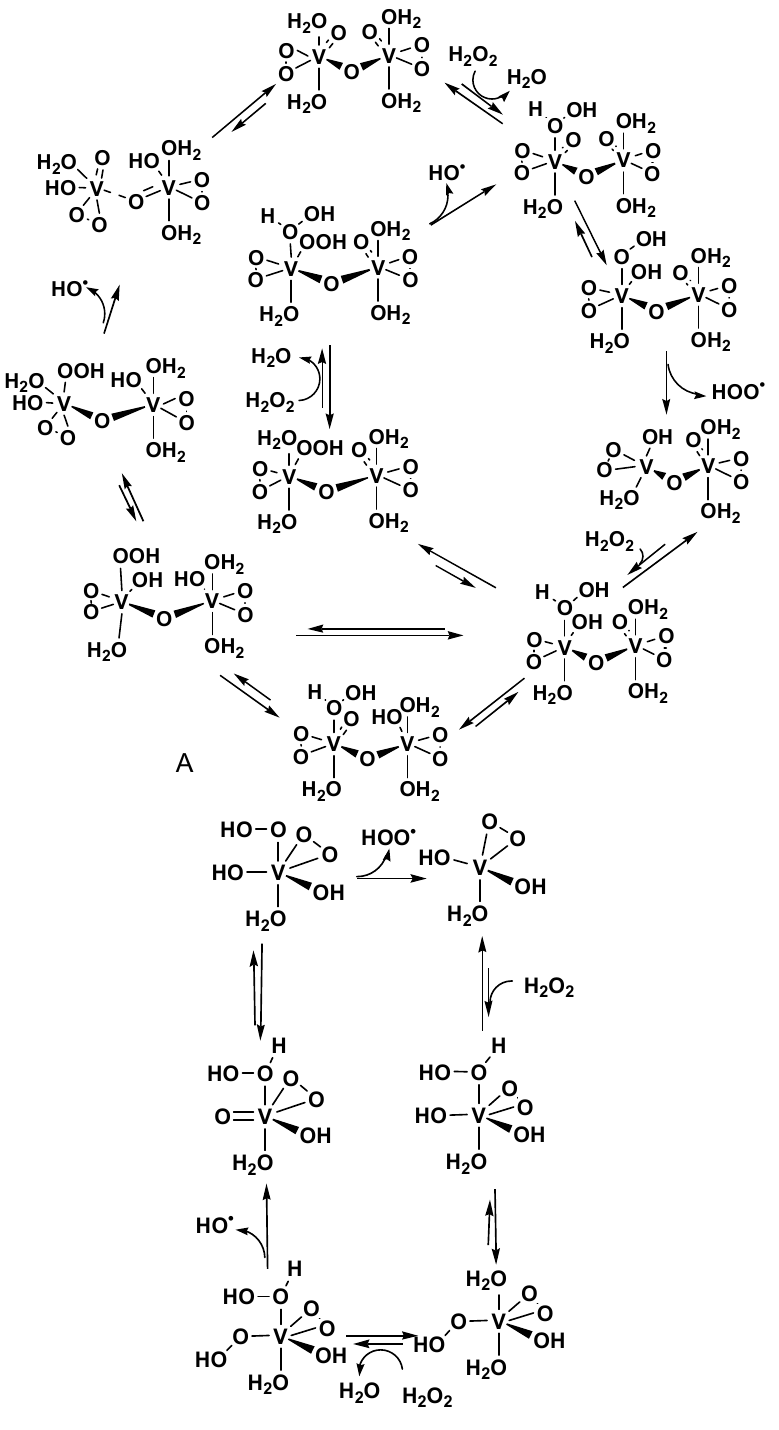
Figure 22. Catalytic cycles of radical generation involving divanadate ( A ) and monovanadate ( B ). Adapted from [158], Copyright (2011) with permission of American Chemical Society.